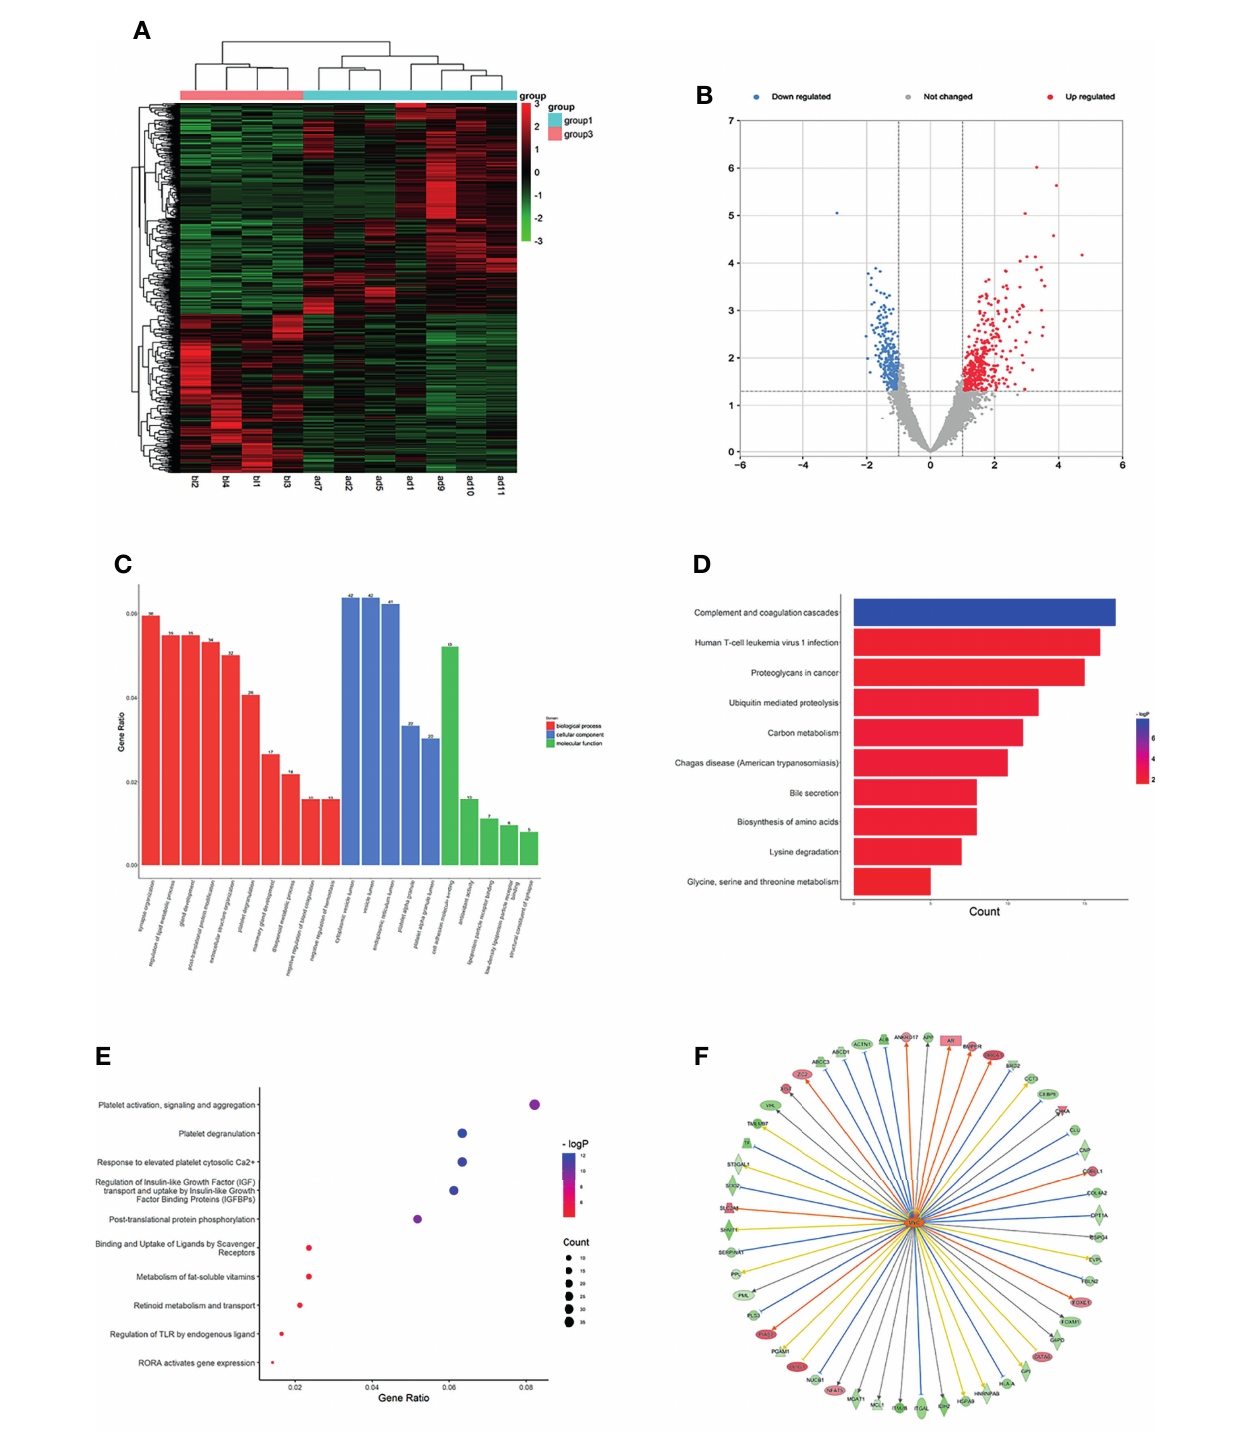
FIGURE 1 | Expression pro fi les of mRNAs in plasma between LUAD patients and LUH negative controls. (A) Heatmap of differentially expressed mRNAs in LUAD patients and controls (group 1, LUAD plasma; group 3, LUH plasma). (B) Volcano plot of differentially expressed mRNAs (read, upregulated genes; green, downregulated genes). (C) Enrichment analysis of GO terms and pathways of the differentially expressed mRNAs, comprising biological process (BP), molecular function (MF), and cellular component (CC). (D) The top 10 KEGG terms for the differentially expressed mRNAs between two groups. (E) Reactome pathway analysis was performed to evaluate the underlying pathway. (F) Ingenuity pathway analysis predicted MYC as a major activation of transcription regulator in